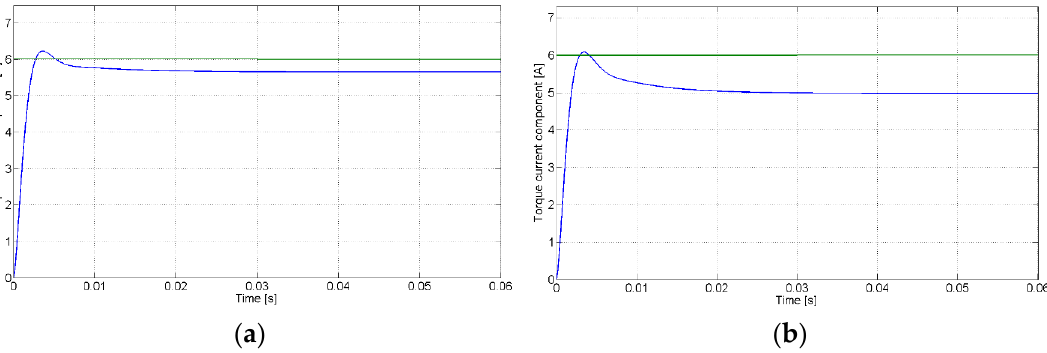
Figure 8. Simulation results: reference (green) and actual (blue) torque-producing stator current without decoupling; ( a ) total moment of inertia J t = 0.043 kgm 2 (including DC machine), steady-state value of torque-producing stator current is 5.65 A; ( b ) total moment of inertia J t = J M = 0.013 kgm 2 (induction motor only), steady-state value of torque-producing stator current is 4.98 A.